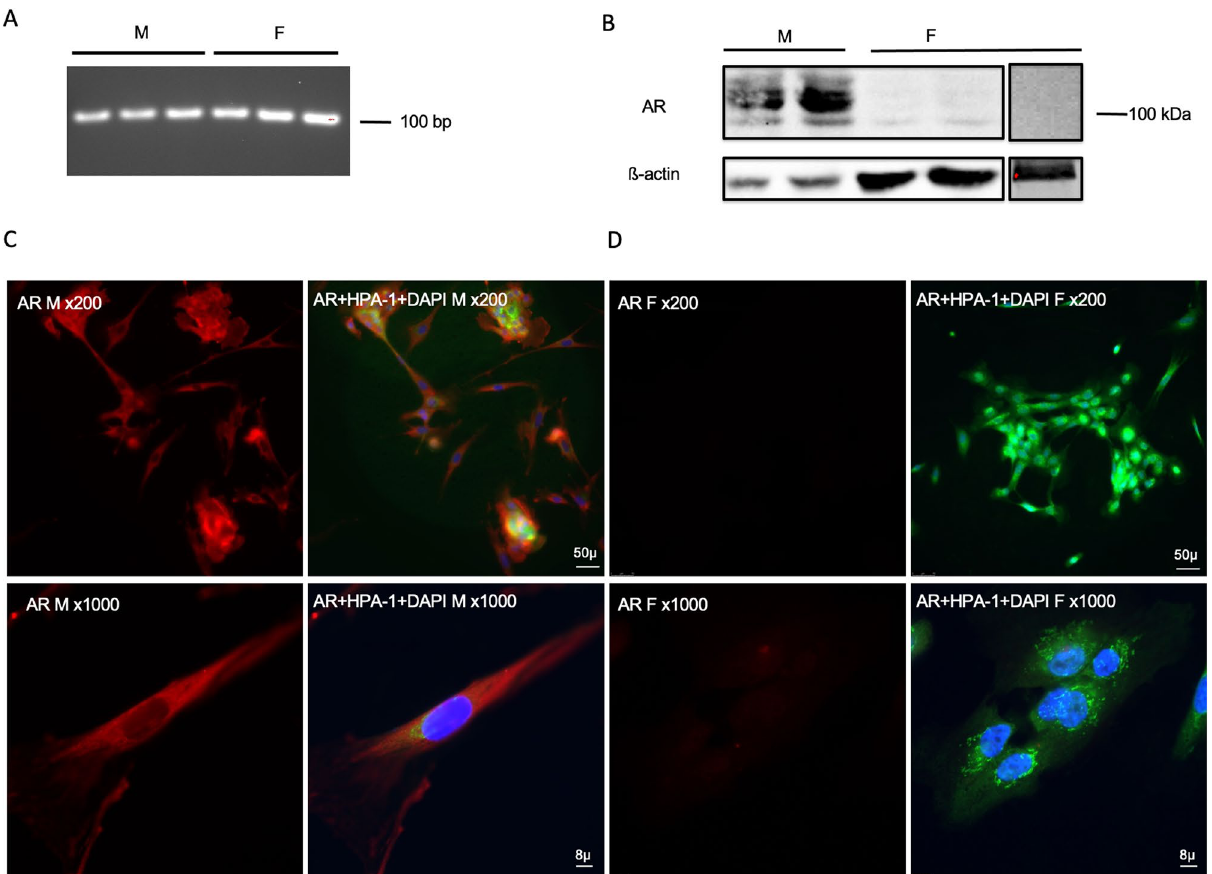
Figure 3. Identification of AR in human conjunctival goblet cells cultured from males and females. RNA was isolated from cultured goblet cells and RT-PCR performed using primers for human Ar . A single band was detected at around 100 bp in samples from both males (M) and females (F) ( A ). Protein samples were collected from cell pellets and Western Blot analysis was performed using antibody against AR. A major band at 100 kDa was detected in males while no immunoreactivity was detected in females ( B ). Immunofluorescence microscopy was performed on cultured goblet cells using antibodies to AR ( C and D ). ( C ) Indicate immunofluorescence to AR (red) in male cells; ( D ) indicate immunofluorescence to AR (red) in female cells; an overlay of anti-AR, HPA-1 (green, indicates the secretory granules of goblet cells), and DAPI (blue, indicates cell nuclei) is shown next to the single channel image of AR. Magnification was × 200 in the upper panels; × 1000 in the lower panels. Original blots/gels are presented in Supplementary Figs. 5 and carbachol-induced Ca 2+ response in either males or females (Supplemental Data 3A,B,E). Similarly, neither DHT, E1, nor E2 incubated for 30 min blocked the histamine-induced Ca 2+ response (Supplementary Fig. 3C,D,F). To determine the action of long-term stimulation with sex hormones, goblet cells were incubated with DHT, E1, E2 or buffer for 24 h before adding LTB 4 . In male cells, LTB 4 10 –8 M significantly increased the [Ca 2+ ] i to 404.70 ± 135.90 nM from basal (Fig. 6A,B). Treatment for 24 h with DHT or E2 significantly decreased the [Ca 2+ ] i to 63.21 ± 11.24 nM ( p < 0.05); and 55.78 ± 9.49 nM ( p < 0.05), respectively. In contrast, 24 h treatment with E1 dampened but did not significantly decrease the [Ca 2+ ] i to 127.60 ± 41.24 nM (Fig. 6B). In cells from females, LTB 4 10 –8 M significantly increased the [Ca 2+ ] i to 463.90 ± 122.60 nM (Fig. 6C,D) and to 458.6 ± 118.3 (Fig. 6E,F) from basal. Incubation for 24 h with DHT, E1, or E2 each significantly decreased the LTB 4 -triggered [Ca 2+ ] i increase to 58.52 ± 6.54 nM ( p < 0.05), 85.18 ± 21.16 nM ( p < 0.05) (Fig. 6C,D), and 94.17 ± 44.96 nM ( p < 0.05) (Fig. 6E,F), respectively. The long-term action of sex hormones was determined for carbachol and histamine using the same experi- mental protocol as for LTB 4 . Neither DHT, E1, nor E2 incubated for 24 h blocked the carbachol- or histamine- induced Ca 2+ response in either males or females (Supplemental Data 4).